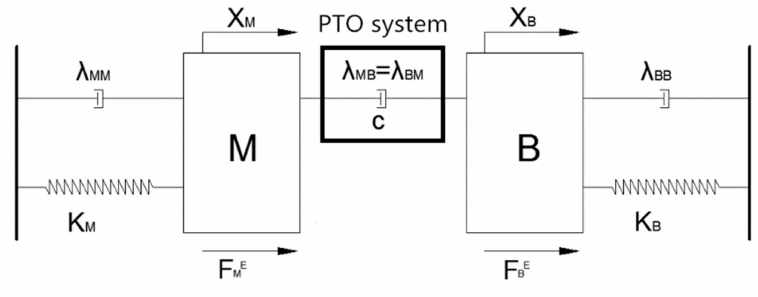
Figure 2. Two degrees of freedom vibration system in the vertical